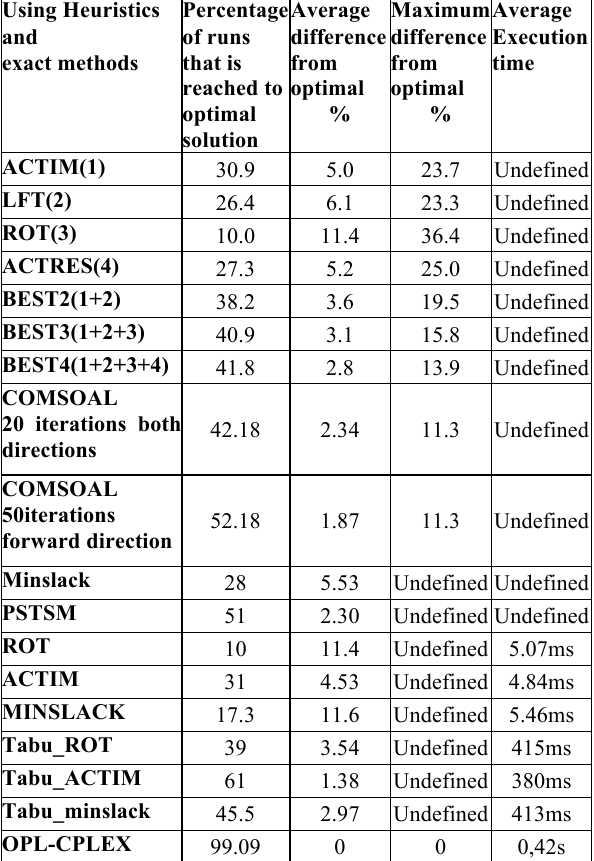
Table 3. The results of using heuristics and exact methods for